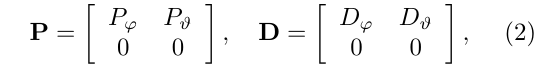
and s at the a h